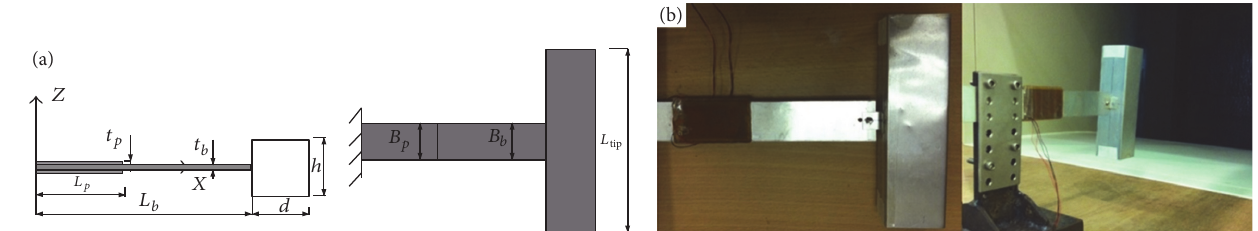
Figure 1: (a) Schematic and (b) fabricated prototype of galloping energy harvester with a square bluff body [32].